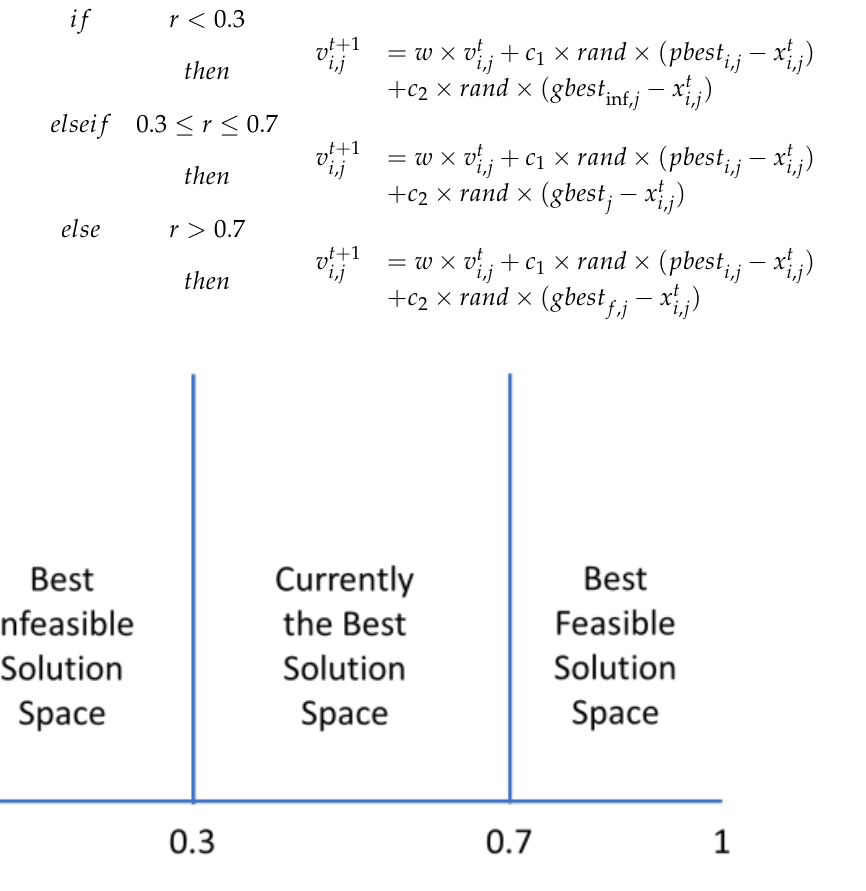
Figure 1 presents a flowchart of the solution algorithm.